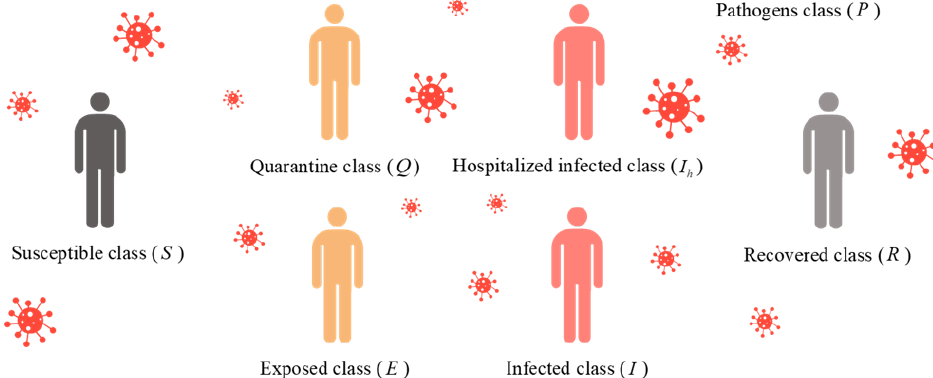
Figure 1. The population class of SQEIRP model used to determine the COVID-19